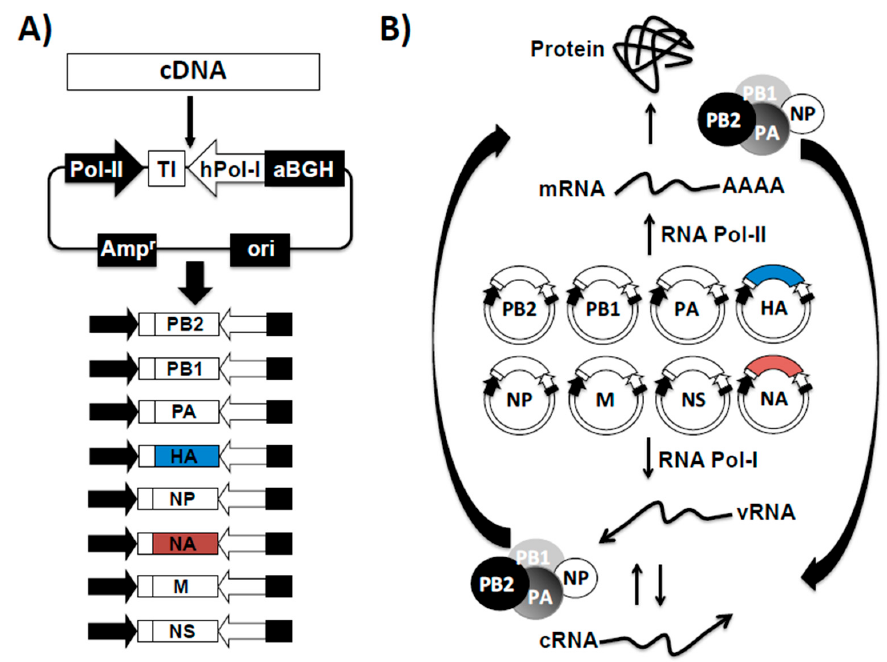
Figure 3. Influenza vRNA cloning into bi-directional rescue plasmids. ( A ) Schematic representation of an ambisense plasmid, influenza cDNA inserts and generation of influenza rescue plasmids: The ambisense plasmid is a bi-directional vector containing the human polymerase I promoter (hPol-I, white arrow) and the mouse Pol-I terminator (TI, white box) sequences to direct the synthesis of the influenza vRNAs. Transcription from the Pol-I cassette results in vRNAs identical to those present in influenza virus, allowing their recognition by the influenza polymerase complex. In opposite orientation to the Pol-I cassette, a polymerase II-dependent cytomegalovirus promoter (Pol-II, black arrow) and a polyadenylation sequence (aBGH, black box) direct the synthesis of influenza proteins from the same viral cDNAs; ( B ) Influenza plasmid-based reverse genetics: In cells transfected with the influenza ambisense plasmids, the Pol-I cassette generates the eight negative sense vRNAs ( bottom ) while the Pol-II directs the synthesis of the eight viral mRNAs ( top ) that are translated into the influenza viral proteins. After translation, influenza NP and polymerase complex PA, PB1 and PB2 associate with the vRNAs to form the viral ribonucleoprotein (vRNP) complexes and initiate transcription from the viral promoter located within the non-coding regions at the 3 ′ termini of the vRNAs. Transcription results in the synthesis of more mRNAs and proteins. The influenza polymerase complex also replicates the vRNAs into complementary (c)RNAs that serve as templates for the amplification of vRNAs. Newly-synthesized vRNAs, together with the structural viral proteins result in the formation of new influenza viruses. Blue and red boxes indicates the HA and NA of seasonal influenza viruses to be included in either the IIV or the LAIV vaccine, respectively. Amp r : ampicillin resistance gene; Ori: plasmid origin of replication.